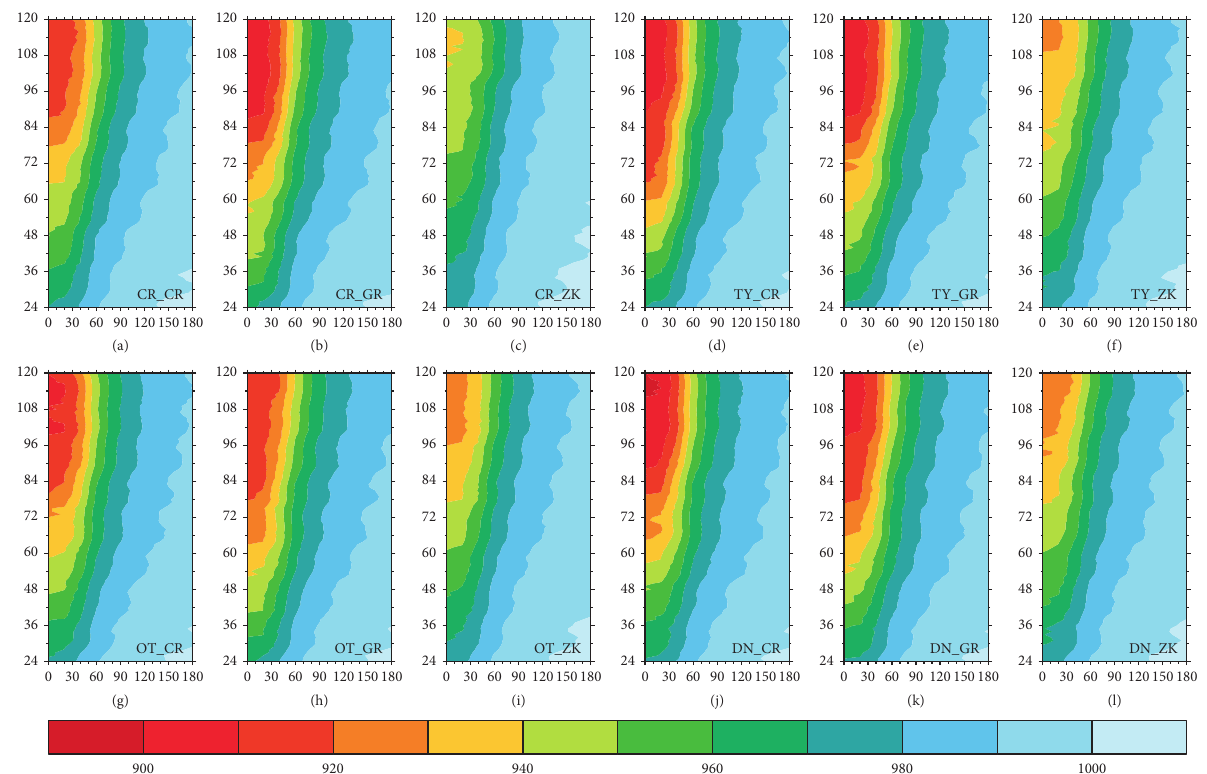
Figure 5: Hovm¨oller diagrams of azimuthally averaged sea level pressure (hPa) from 12 experiments. x -axis denotes the distance (km) from the center of the typhoon and y -axis denotes the forecast hours.